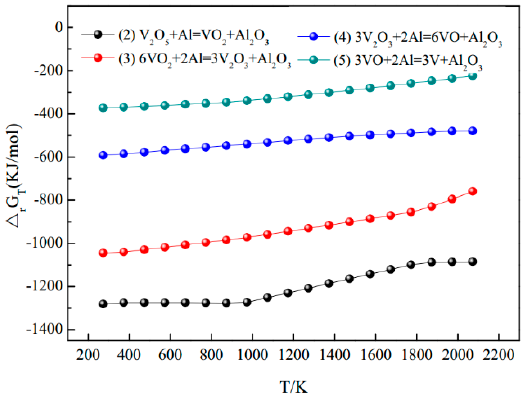
Figure 3. The Δ r G T ‐ T curves of reactions (2)–(5) in standard conditions. Figure 3. The ∆ r G T - T curves of reactions (2)–(5) in standard